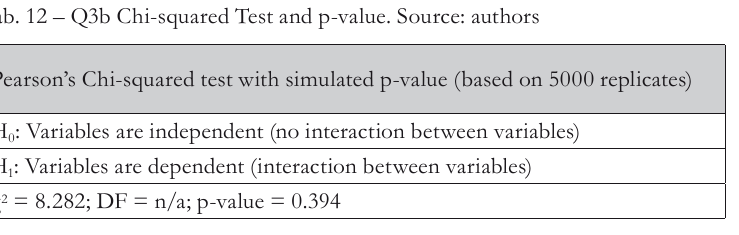
Tab. 12 – Q3b Chi-squared Test and p-value. Source: